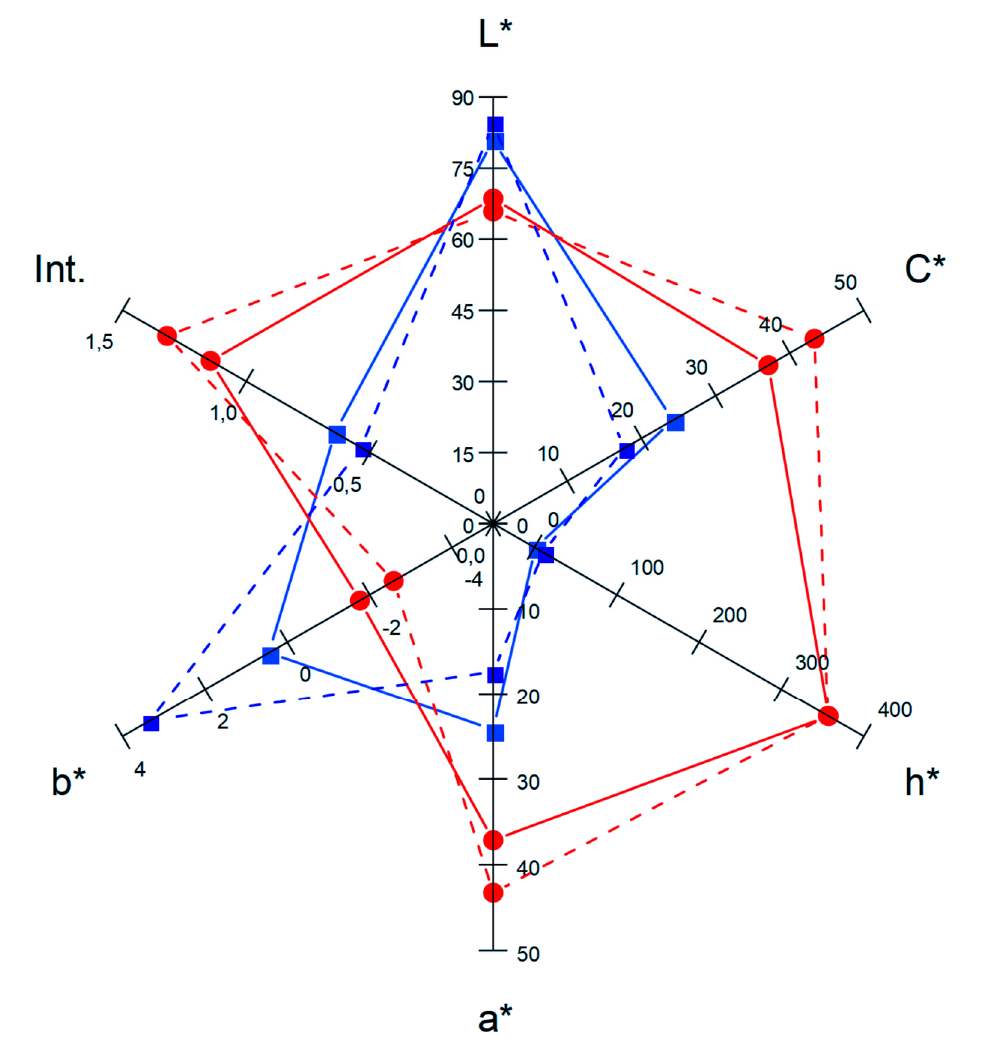
Figure 3. CIELab coordinates of juices obtained from untreated and PEF-treated grapes at the moment when they were obtained and after 45 days of storing at 4 °C. Juice obtained from untreated grapes (blue solid lines), juice obtained from PEF-treated grapes (red solid lines), juice obtained from untreated grapes after 45 days of storing at 4 °C (blue dashed lines), juice obtained from PEF-treated grapes after 45 days of storing at 4 °C (red dashed lines).